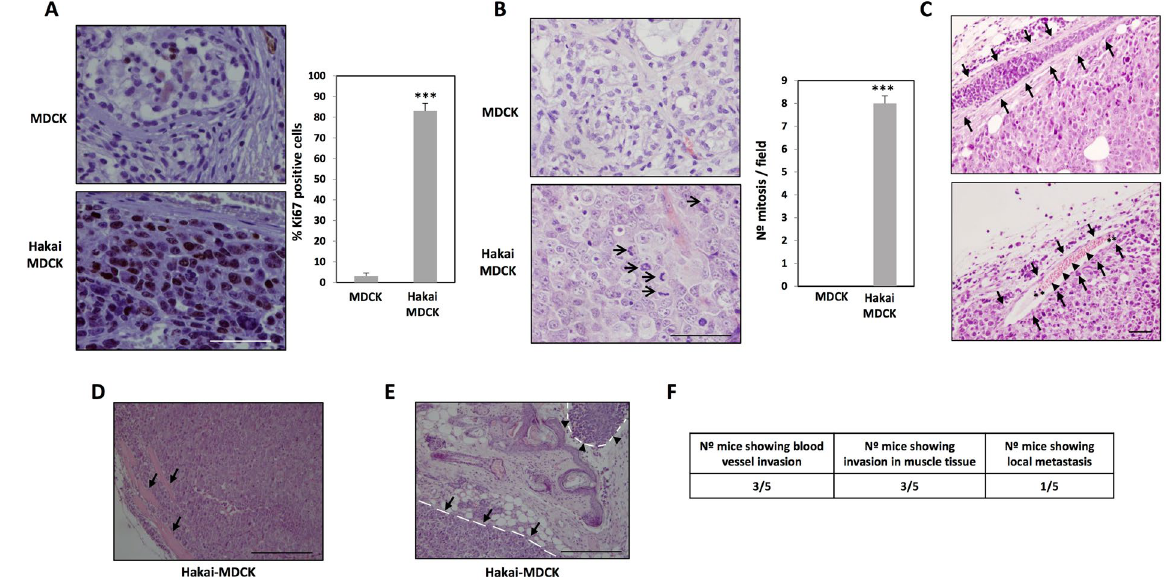
Figure 3. Hakai action on tumour proliferation and invasion in a mouse xengraft model. (A) Immunohistochemistry for ki67 expression in teratoma and tumours originated by MDCK or Hakai-MDCK cells, respectively (MDCK, n = 2; Hakai-MDCK, n = 5, five pictures per each were taken). Representative images were taken with the 40x objective ( left panel ) and the quantification of the percentage of positive cells is shown ( right panel ). Scale bar, 500 µ m. (B) Mitotic cells in MDCK and Hakai-MDCK xenografts (MDCK, n = 2; Hakai- MDCK, n = 5, five pictures per each were taken). Mitotic cells in representative images of H&E staining taken with a 40x objective ( left panel , arrows ) and the corresponding mitosis quantification in xenografts ( right panel ). Scale bar, 500 µ m. (C) H&E staining in the upper panel shows an infiltrated blood vessel with tumour cells originated by Hakai-MDCK injection, and in the bottom panel a blood vessel containing leukocytes (asterisks) and erythrocytes (arrowheads) is shown. Blood vessels are indicated with arrows. Photograph was taken with a 20x objective. Scale bar, 100 μ m. (D) H&E staining showing muscle infiltration by Hakai-MDCK cells. Picture was taken with a 10x objective. Muscle is indicated with arrows. Scale bar, 500 μ m (E) H&E staining showing primary tumour (arrows) and a local metastasis (arrowheads) originated by Hakai-MDCK cells are indicated with a discontinuous line. Connective tissue is found between the primary tumour and the local metastasis. Picture was taken with a 10x objective. Scale bars, 500 µ m. Quantifications are shown as mean ± SEM ( *** P < 0,001). (F) Table including the number of animals containing infiltrated tumour cells in blood vessels